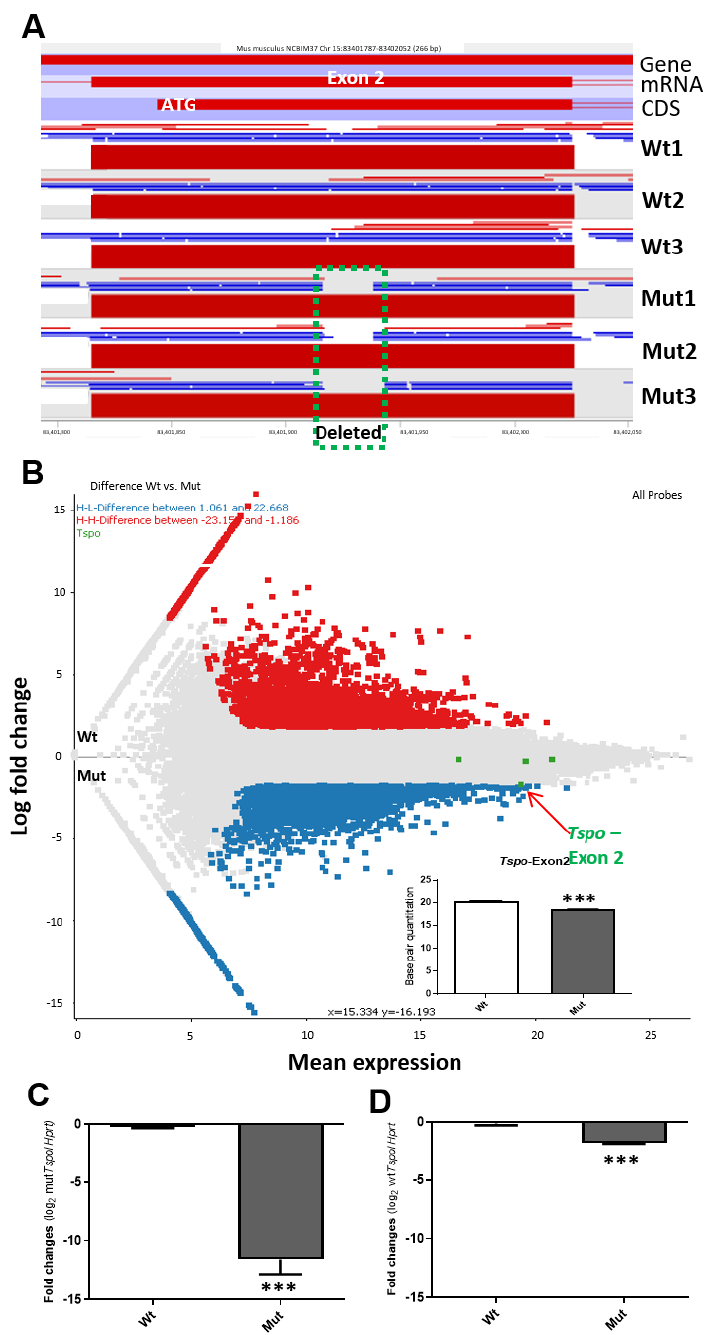
Figure 1. The genome mapping of Tspo exon2 after CRISPR/Cas9-mediated genome editing and the transcriptome changes under TSPO deficiency. ( A ). RNA-seq mapping of transcripts onto the Tspo exon 2. Gene, mRNA, CDS (coding sequence), and ATG are indicated. Deleted area is indicated as green square dotted line. Wt1, Wt2 and Wt3: three wild-type cell populations; Mut1, Mut2 and Mut3: three mutated cell line populations. ( B ). M-A plot of the comparison of RNA-seq data from Wt vs. Mut, by transforming the data differences onto M (log ratio, Y-axis) and A (mean average, x-axis) scales. Each exon of Tspo gene is indicated by green dots: exon2, where there is a small deletion, is indicated and shown to be significantly lower than that in Wt, using base pair quantitation as shown in bar graph. The rest of the exons show no significant differences. Each dot represents each exon; Red dots, highly expressed genes after TSPO depletion and blue dots, the less expressed genes after TSPO depletion; the grey dots are exons showing no dramatic changes between Mut and Wt cells. Inset, base pair quantitation of exon 2 of Tspo gene, which was partially deleted by the CRISPR/Cas9 genome editing. ***, p value < 0.001 (student t -test, n = 3). C–D. Real-time PCR of Tspo Mut transcripts using one of the primers located within the deleted area as shown in A ( C ) and the rest of the undeleted exon regions ( D ). ***, p value < 0.001 (student t -test, n =